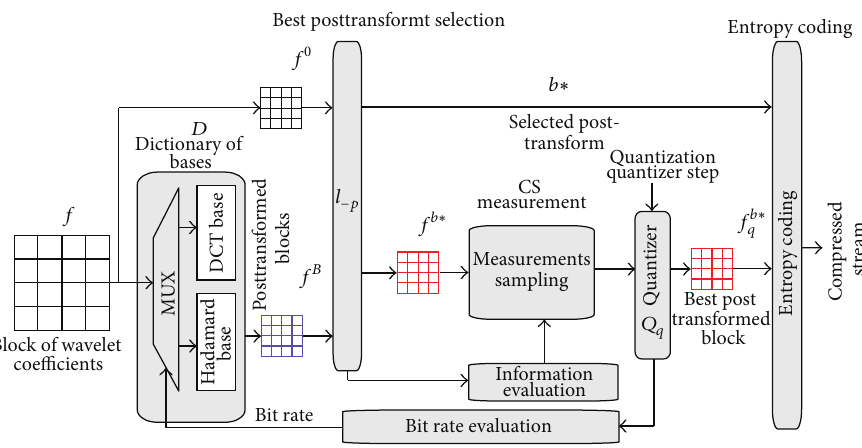
Figure 3: Proposed deep coupling coding between PT and